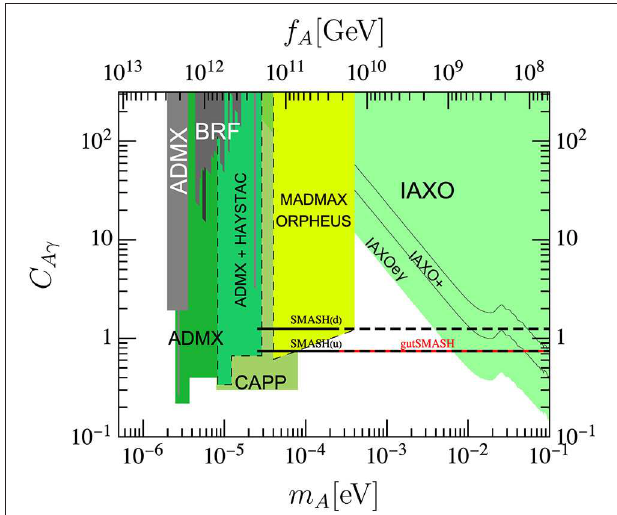
FIGURE 7 | SMASH predictions for the axion-photon coupling [adapted and used with permission from Ballesteros et al. (2017b)]: SMASH(u,d) (thick solid horizontal lines for hypercharge assignment of 1 / 3 (2 / 3) for Q ) and − gutSMASH (red). The continuing dashed lines show plausible uncertainties. We also show, in gray, the current bounds on axion DM [ADMX (Boutan et al., 2018; Du et al., 2018 ), BRF] and, in green, prospects for next generation axion dark matter experiments, such as ADMX (Boutan et al., 2018; Du et al., 2018), CAPP ( Chung, 2018), HAYSTAC (Zhong et al., 2018), MADMAX (Caldwell et al., 2017; Brun et al., 2019 ), ORPHEUS (Morris, 1984; Rybka et al., 2015), and the helioscope IAXO (Armengaud et al., 2014) (fiducial, extended + sensitivities to the axion-photon channel and IAXOe γ for the electron-photon channel).